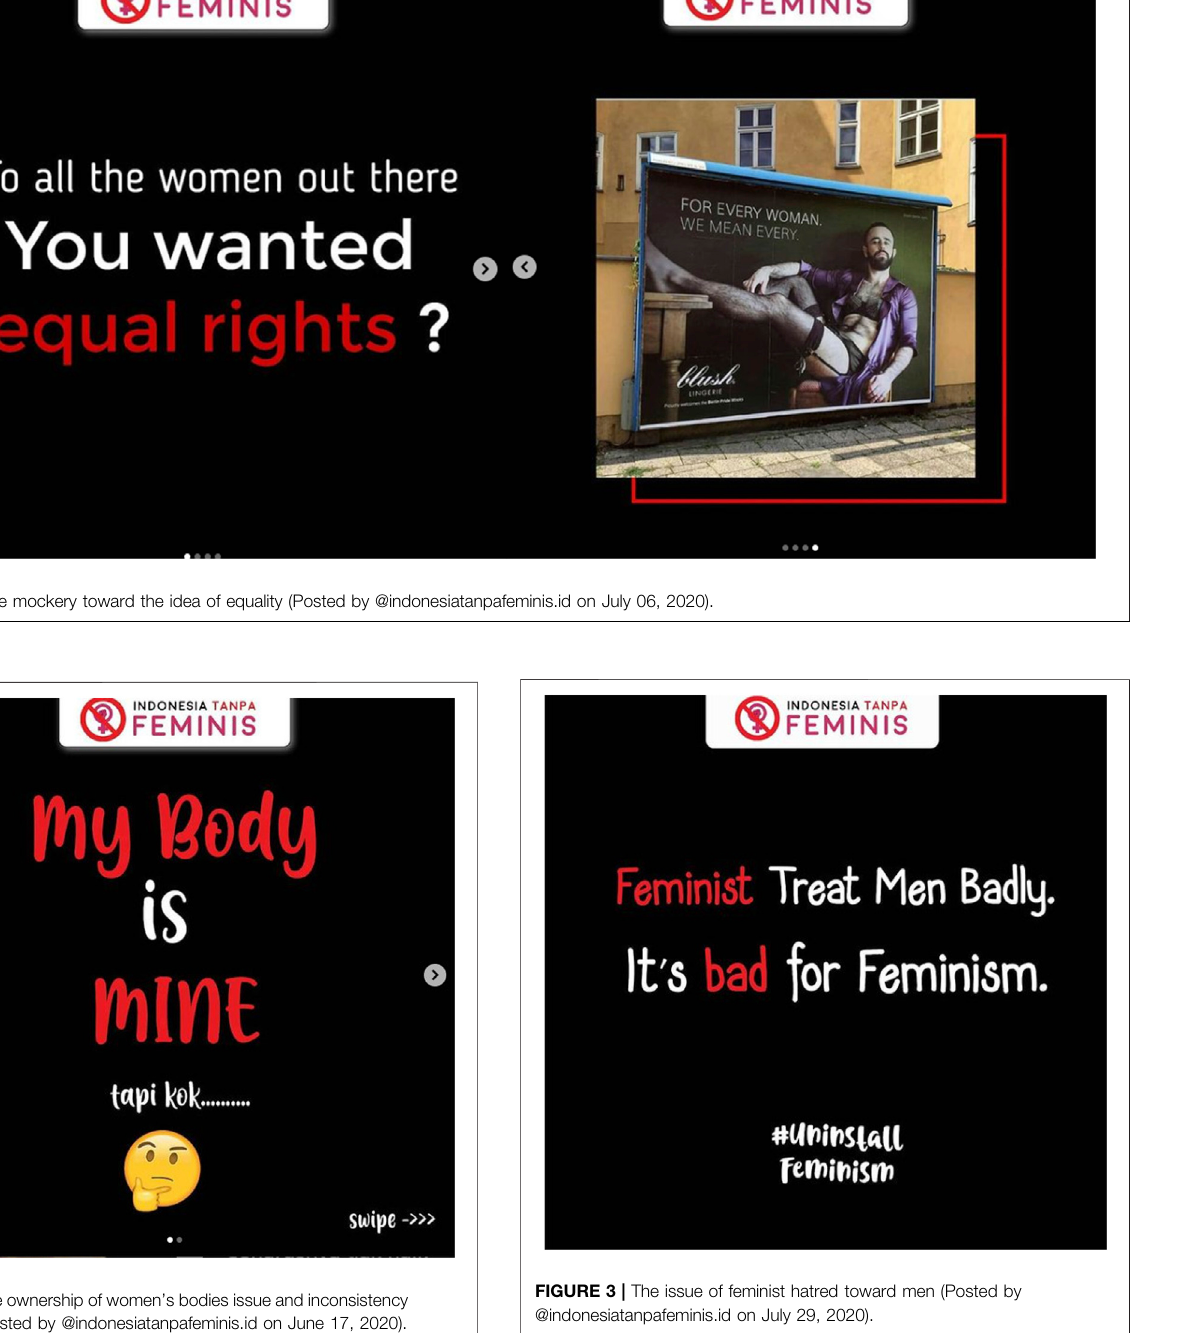
Frontiers in Sociology |